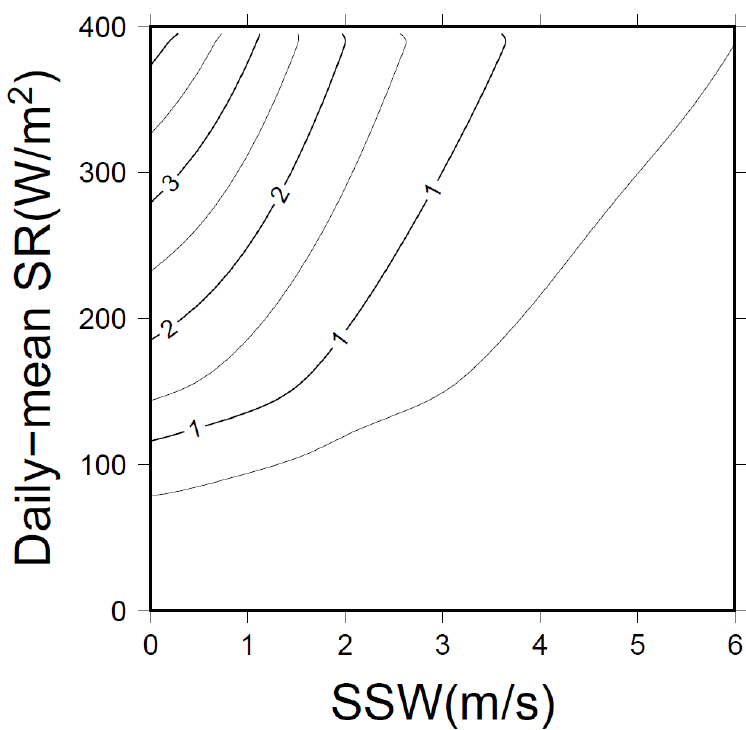
Figure 1. Diurnal sea surface temperature range ( δ SST) estimated from Equation (1) as a function of daily mean solar radiation (SR) and sea surface wind (SSW) used in this study. The first-guess sea surface temperature (SST) is assumed to be 25 ◦ C as the foundation SST. The contour is δ SST with the interval 0.5 ◦ C.